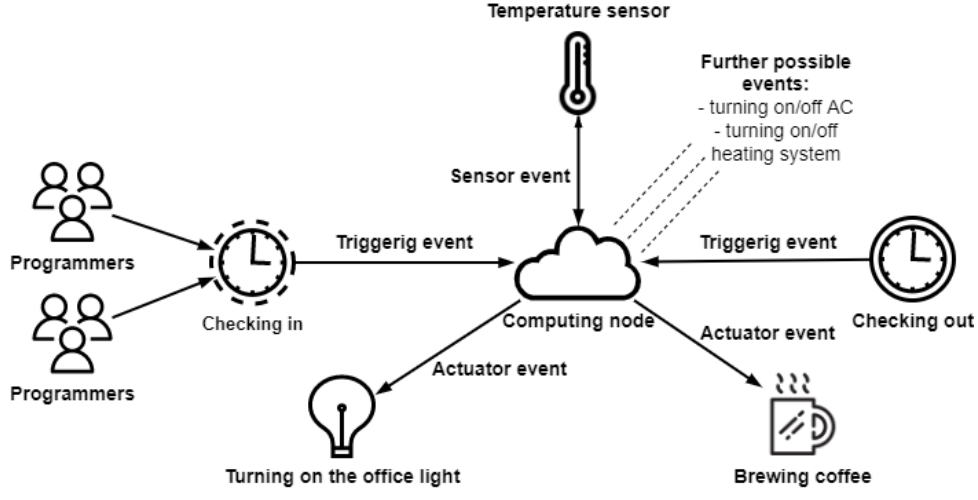
Figure 1. Office routine